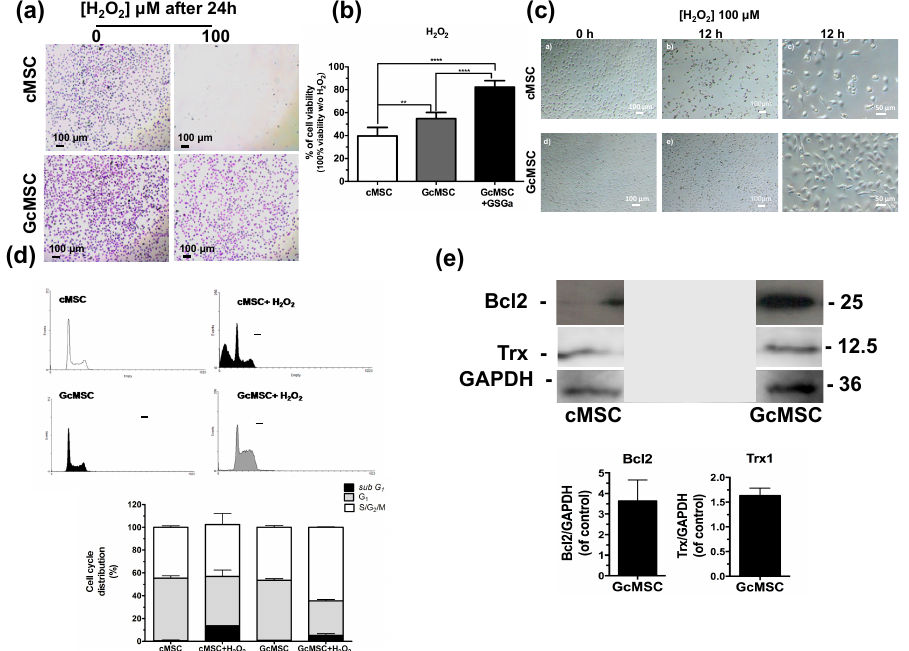
Figure 6. Prolonged GSGa treatment for selection of oxidation-resistant cMSC line. ( a ) Micrographs of cMSC and GcMSC seeded at 1 × 10 4 cells/cm 2 of density, after 24 h from seeding in the presence or absence of H 2 O 2 (100 μ M). Scale bars are 100 μ m. Cells were stained using crystal violet. ( b ) Cell viability of control (cMSC), GcMSC (GcMSC) and of GcMSC in the presence also of 680 μ g/mL of GSGa (GcMSC+GSGa) after 24 h of treatment with H 2 O 2 (100 μ M). The data were obtained by five independent experiments and analyzed using ANOVA one-way test. ( c ) Optical micrographs of cMSC and GcMSC (1 × 10 4 cells/cm 2 of density) at 0 or 12 h of treatment with H 2 O 2 (100 μ M). Scale bars are 100 and 50 μ m; ( d ) FACS profiles (on the top) and histograms of the cell cycle distribution (on the bottom) of cMSC (as control) and GcMSC cultured for 12 h in the presence or in the absence of H 2 O 2 (100 μ M). ( e ) Representative western blot analysis of the expression of Bcl2, Trx1 in cMSC and GcMSC. The original figure is shown in the Supplementary Materials Figure S9. Experiments were performed as three biological replicas. Error bar indicates S.D. ** p value ≤ 0.01; **** p value ≤ 0.0001 (one-way ANOVA).